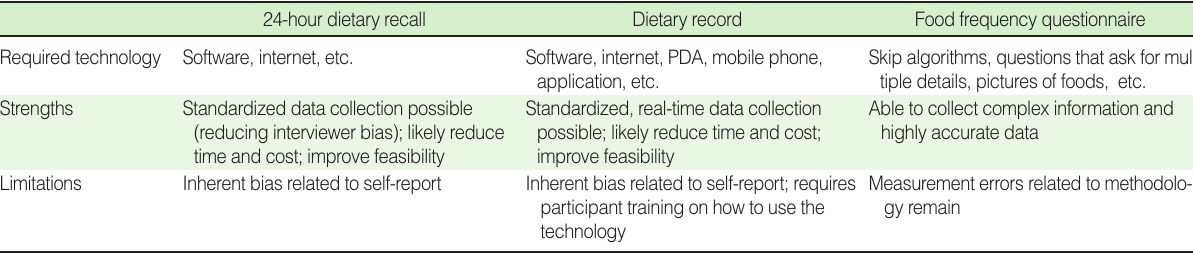
Table 2. Strengths and limitations of new techniques in dietary assessment 24-hour dietary recall Dietary record Food frequency questionnaire Required technology Software, internet,